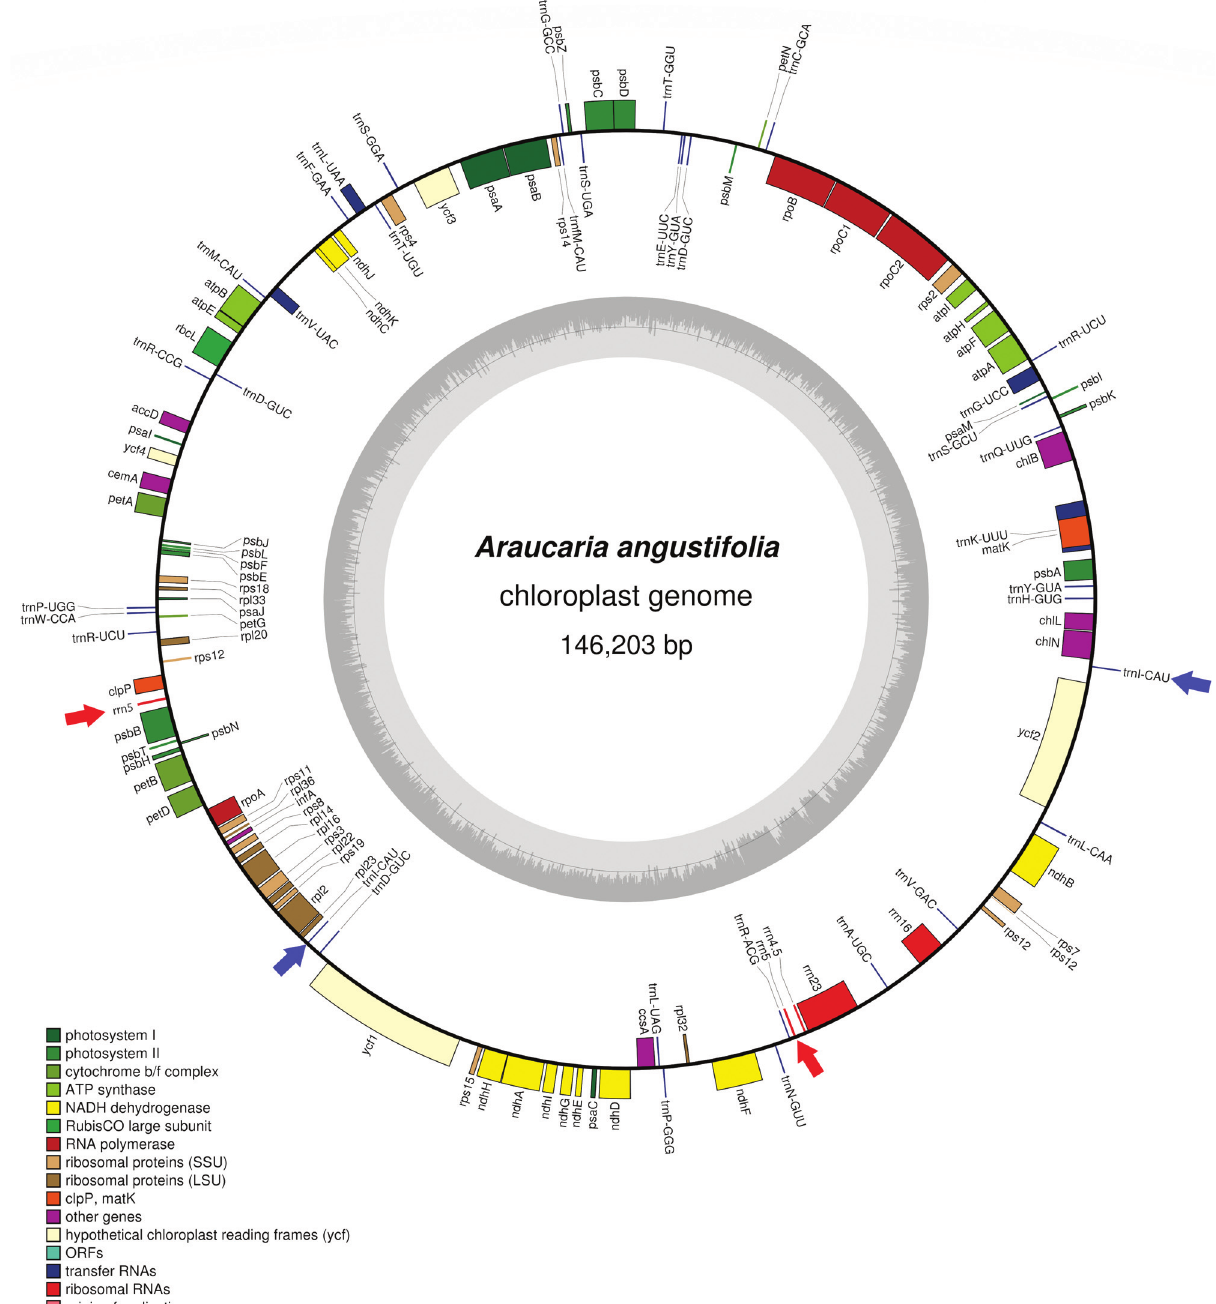
Figure 1 - Gene map of the Araucaria angustifolia chloroplast genome. Genes drawn inside the circle are transcribed counterclockwise and those out- sides are clockwise. Genes belonging to different functional groups are indicated by different tonalities. The darker gray in the inner circle corresponds to the GC content, while the lighter gray corresponds to the AT content. Red and blue arrows indicate, respectively, double inverted copies of the rrn5 and trn I-CAU